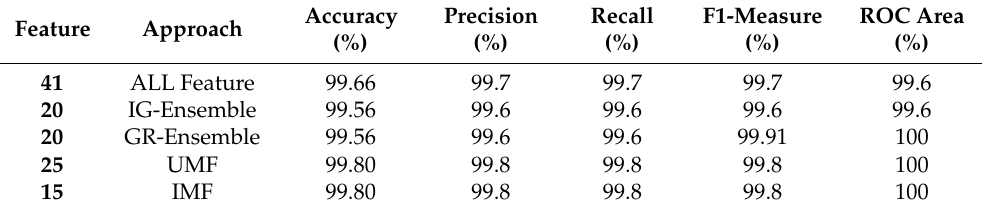
Table 7. Performance metrics of NSL-KDD using ensemble with various selected features.